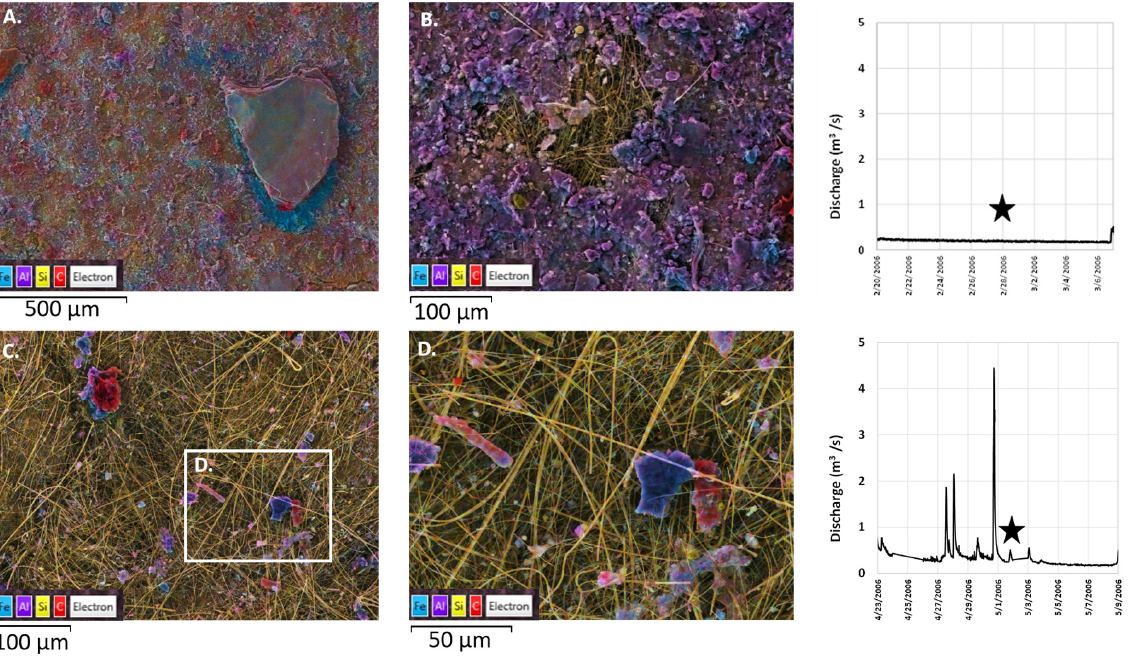
Figure 8. Representative SEM/EDS maps of selected Quebrada Sonadora filters under contrasted flow (as seen on the hydrographs on the right). ( A ) Low magnification composition map of overview area during low flow. ( B ) Composition map at higher magnification of filter in A (area not shown). ( C ) Low magnification image of filter collected during high flow. ( D ) Composition map of focus area D in overview area C. Si-rich fibers in the background are constituents of the filter membrane. Colors represent selected elements (Fe, Al, Si and C). Stars on the hydrographs represent the time when the corresponding filter was collected.